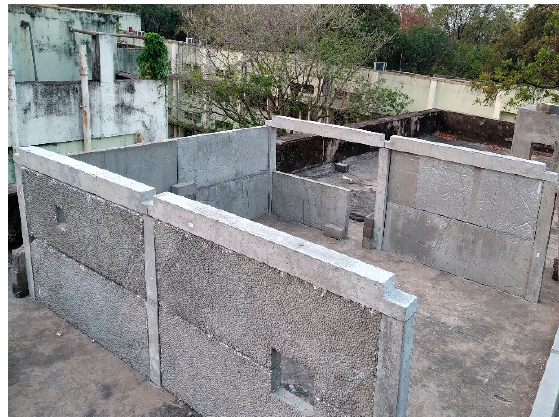
Figure 13. Erection of prefabricated elements.